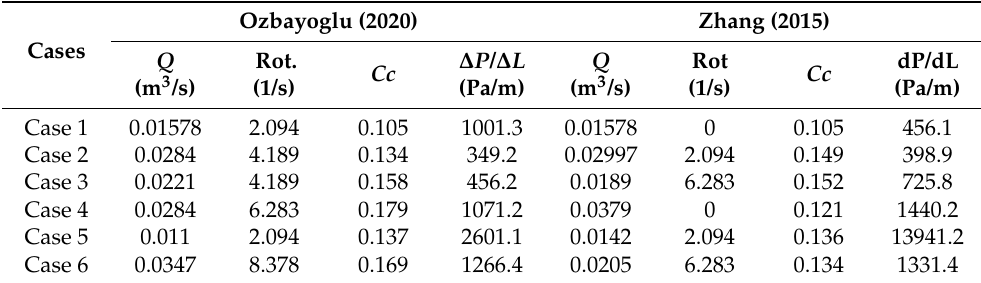
Table 9. Summary of the optimal flow rate and pipe rotation speeds obtained from Figures 7–12.